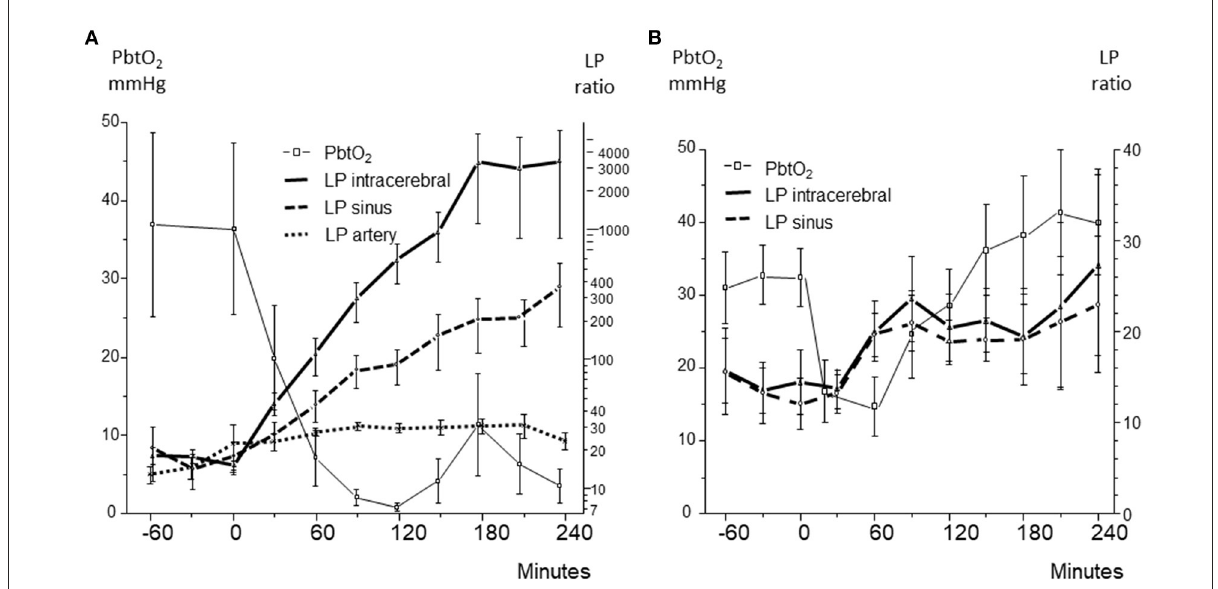
FIGURE10 (A): Brain tissue oxygen tension (PbtO 2 ), and lactate/pyruvate (LP) ratio obtained in brain tissue (intracerebral), superior sagittal sinus (sinus), and femoral artery (artery) during severe, irreversible ischemia after induced hemorrhagic shock. (B): Brain tissue oxygen tension (PbtO 2 ), and lactate/pyruvate (LP) ratio obtained in brain tissue (intracerebral) and superior sagittal sinus (sinus) during reversible hemorrhagic shock. Data from (94, 95) are shown as Mean ±